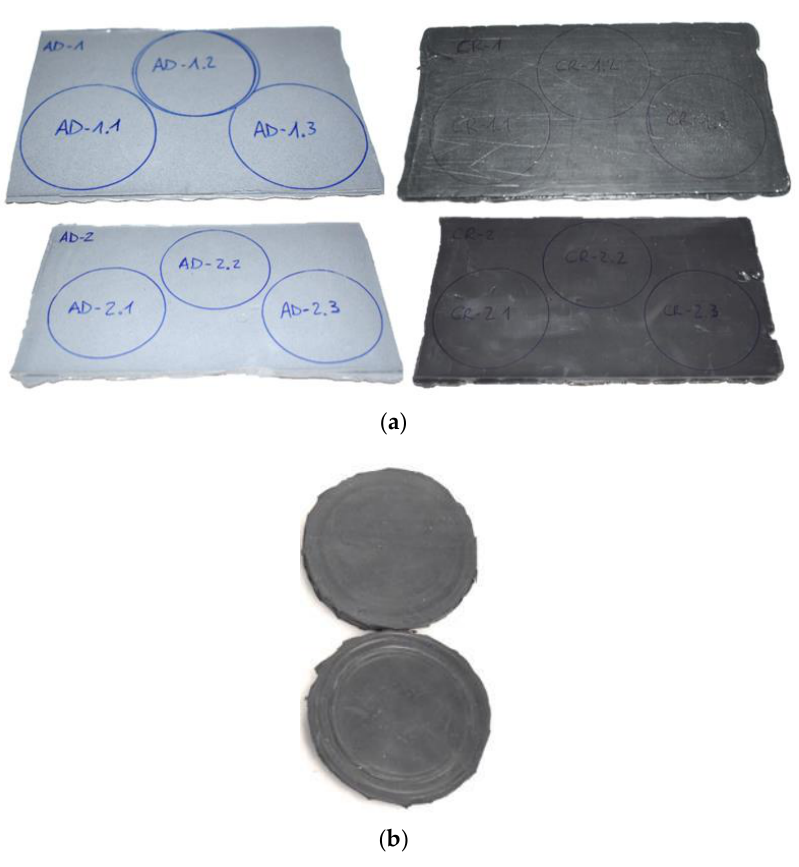
Figure 3. ( a ) Sealant rectangular sheets. ( b ) Specimens for hydrogen permeability test.